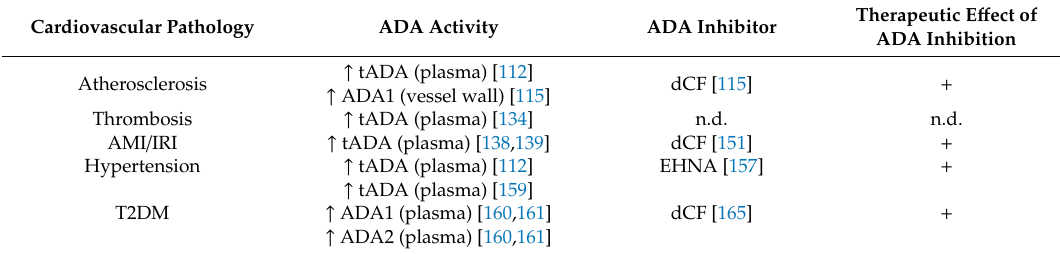
Table 2. Cardiovascular diseases with ADA overactivity and therapeutic e ff ects of its inhibition in experimental